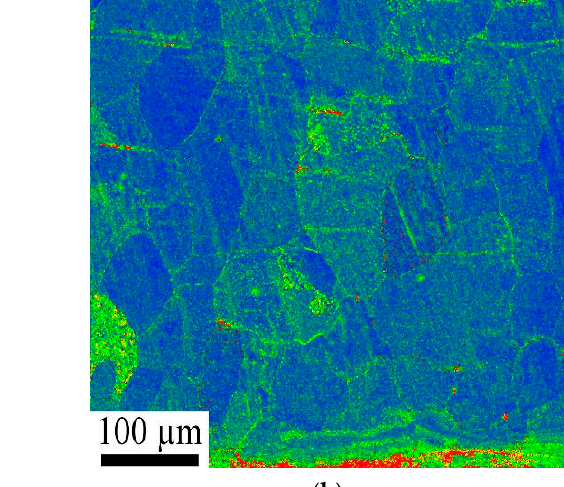
Figure 7. Kernel average misorientation maps of surface layers of ARMCO iron in the initial state ( a ) and after LSP ( b ); the bottom edge of the images corresponds to the surface of the specimen.